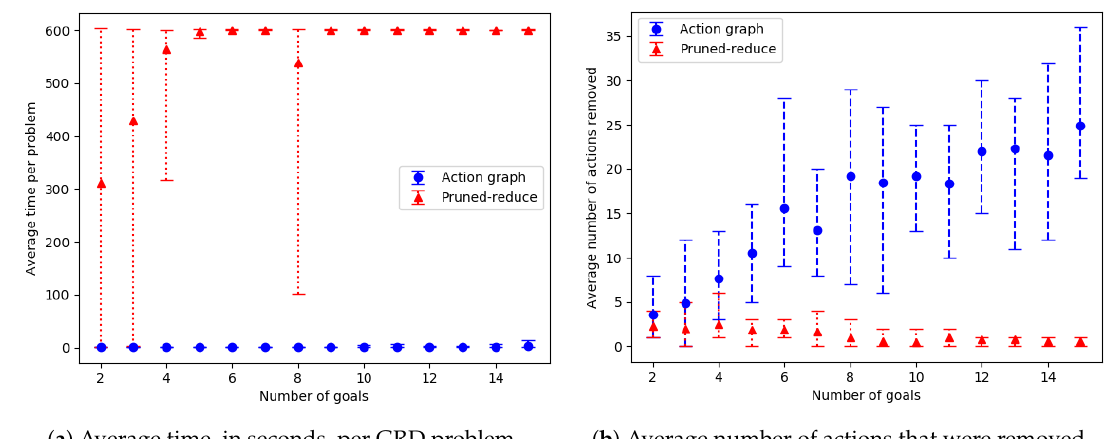
Figure 18. Results for an increasing number of goals. The results of our Action Graph approach are indicated by blue circles, pruned reduce [10] is shown with red triangles. All times are given in seconds.